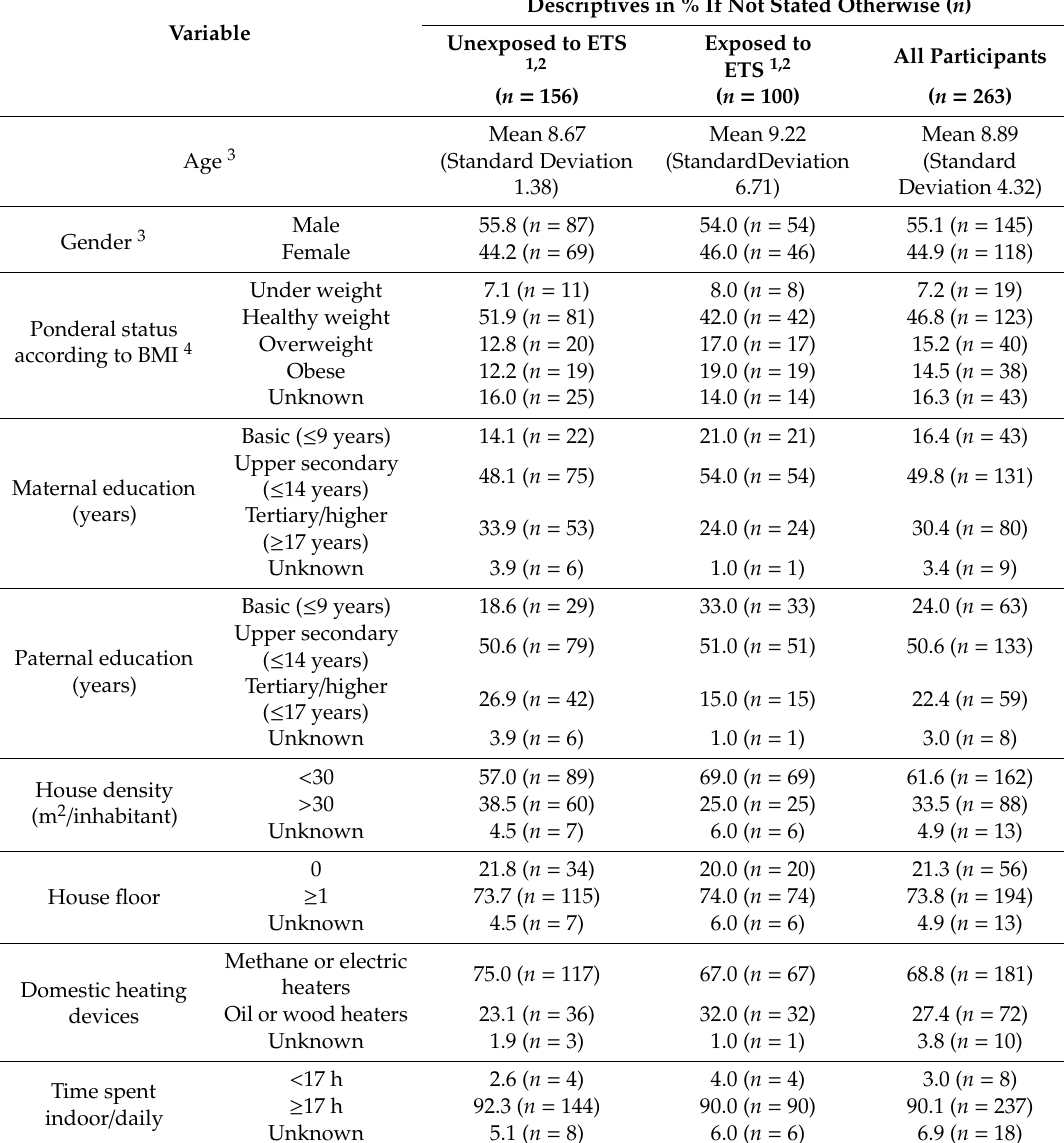
Table 2. Characteristics of the study population participating to the winter biomonitoring